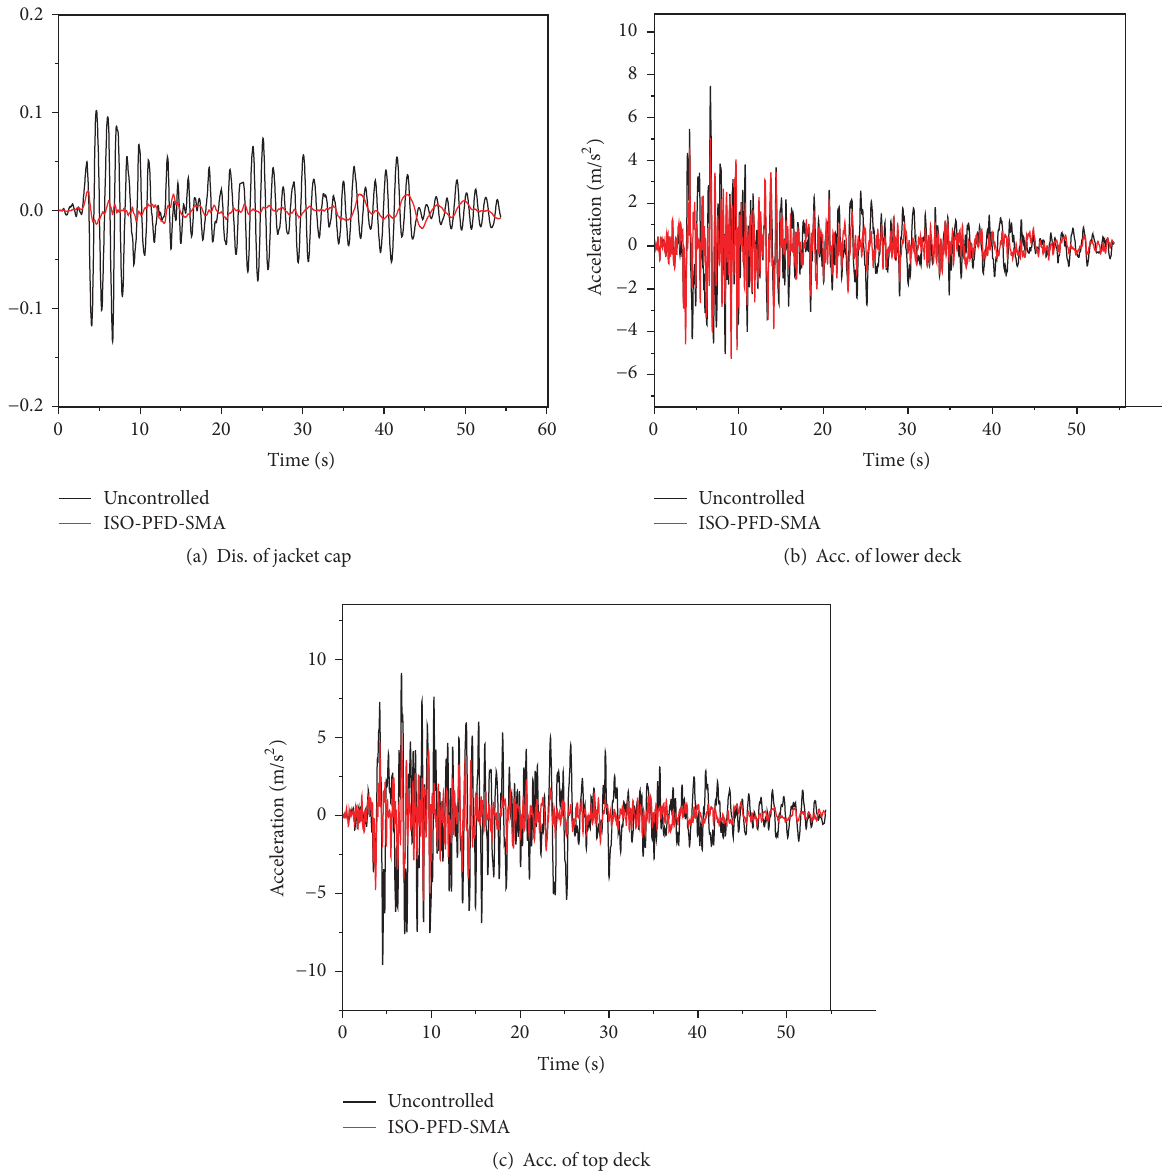
Figure 13: Computational response of JZ20-2MQU model under Taft earthquake